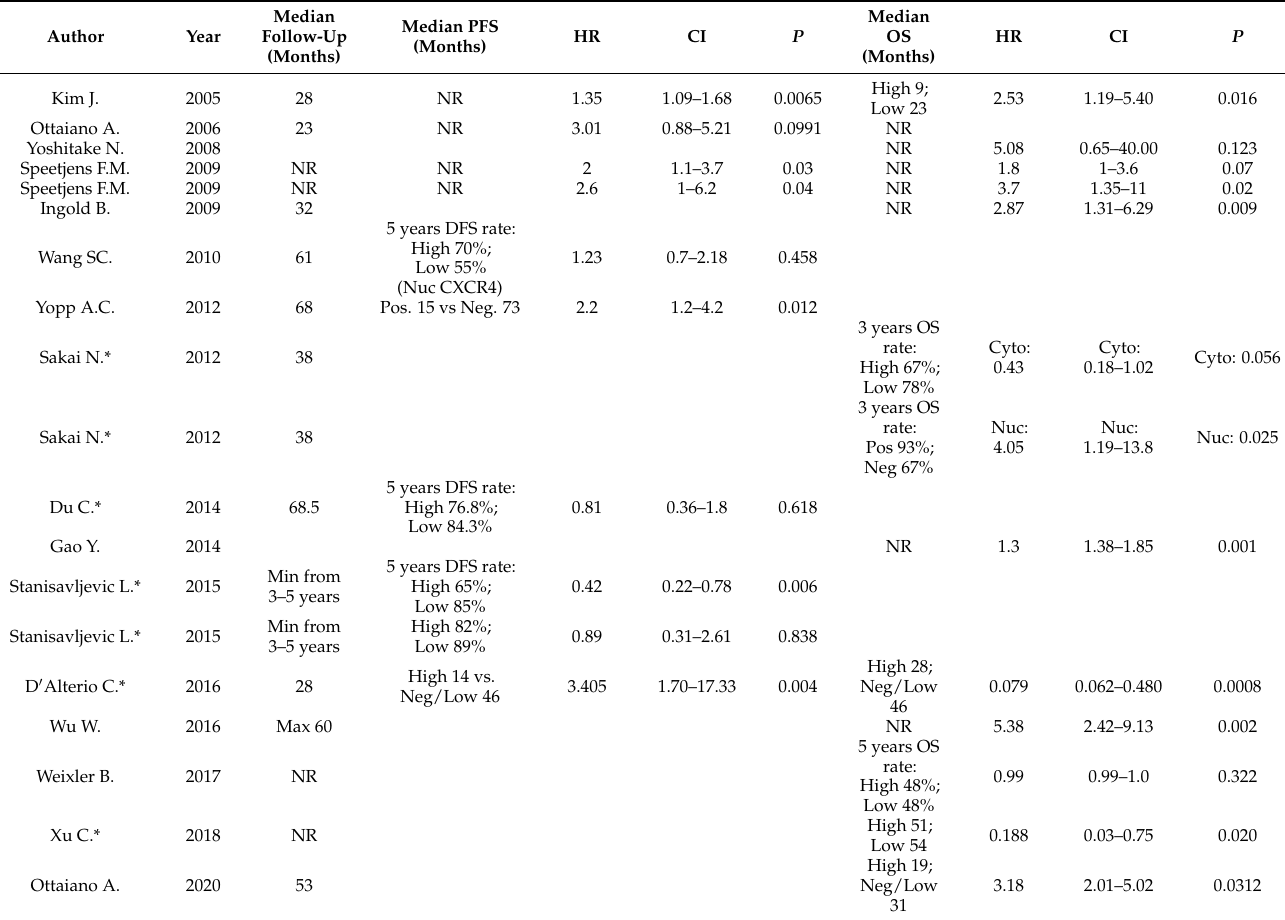
CXCR4 expression. The effect on PFS is shown in Figure 3B where the pooled HR is 1.42